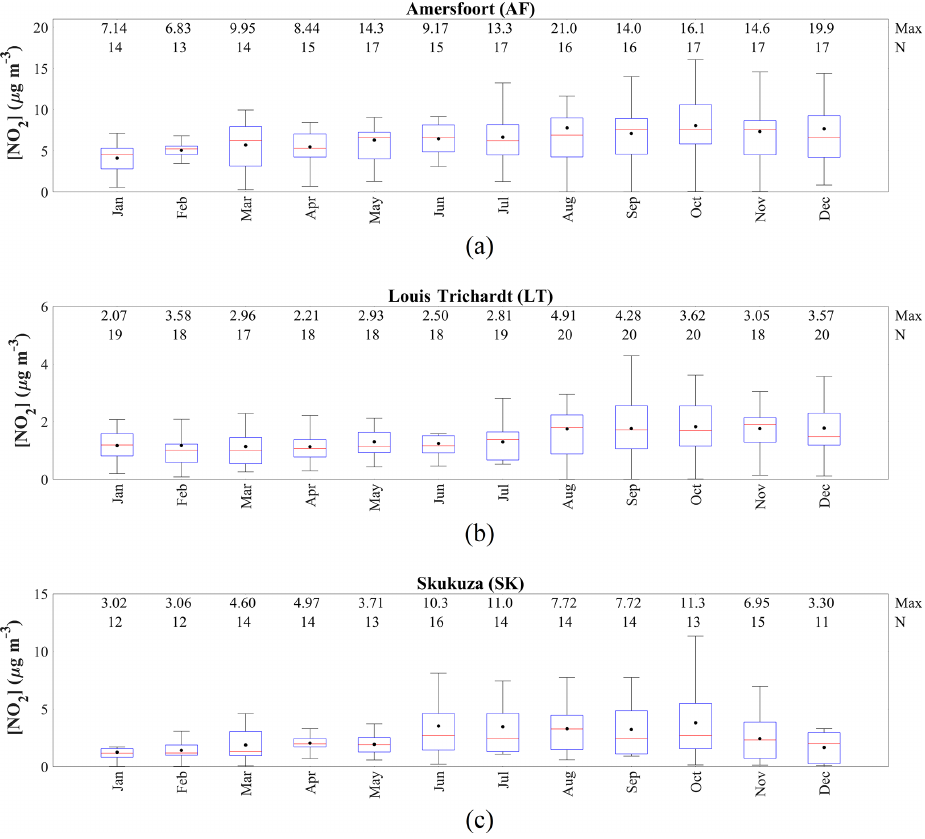
Figure 4. Monthly NO 2 concentrations measured at (a) AF from 1997 to 2015, (b) LT from 1995 to 2015 and at (c) SK from 2000 to 2015. The red line of each box represents the median; the top and bottom edges of the box represent the 25th and 75th percentiles, respectively; the whiskers are ± 2 . 7 σ (99.3% coverage if the data have a normal distribution); and the black dots represent the averages. The maximum concentrations and the number of measurements ( N ) are presented at the